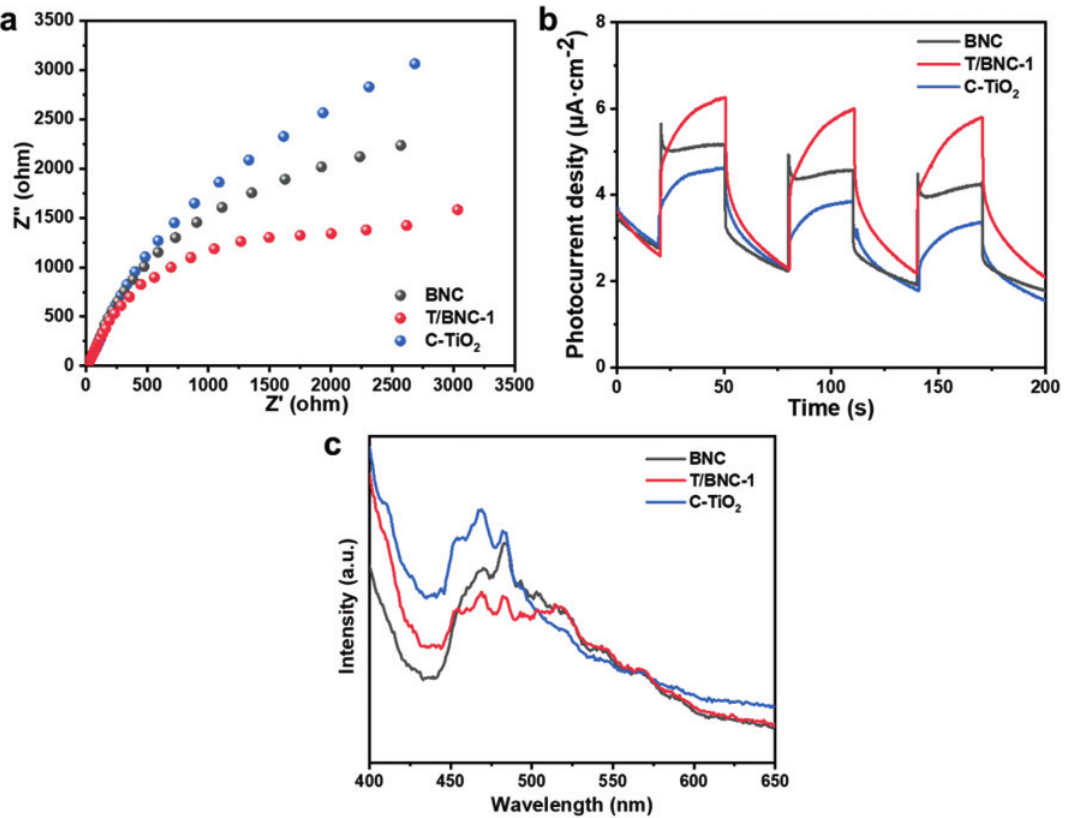
Figure 6: (a) Transient PC of different photocatalysts at 0.5 V bias ( vs. Ag/AgCl) under Xe lamp illumination, (b) electrochemical impedance spectra Nyquist plots and (c) PL spectra of the pristine BNC, C-TiO 2 and